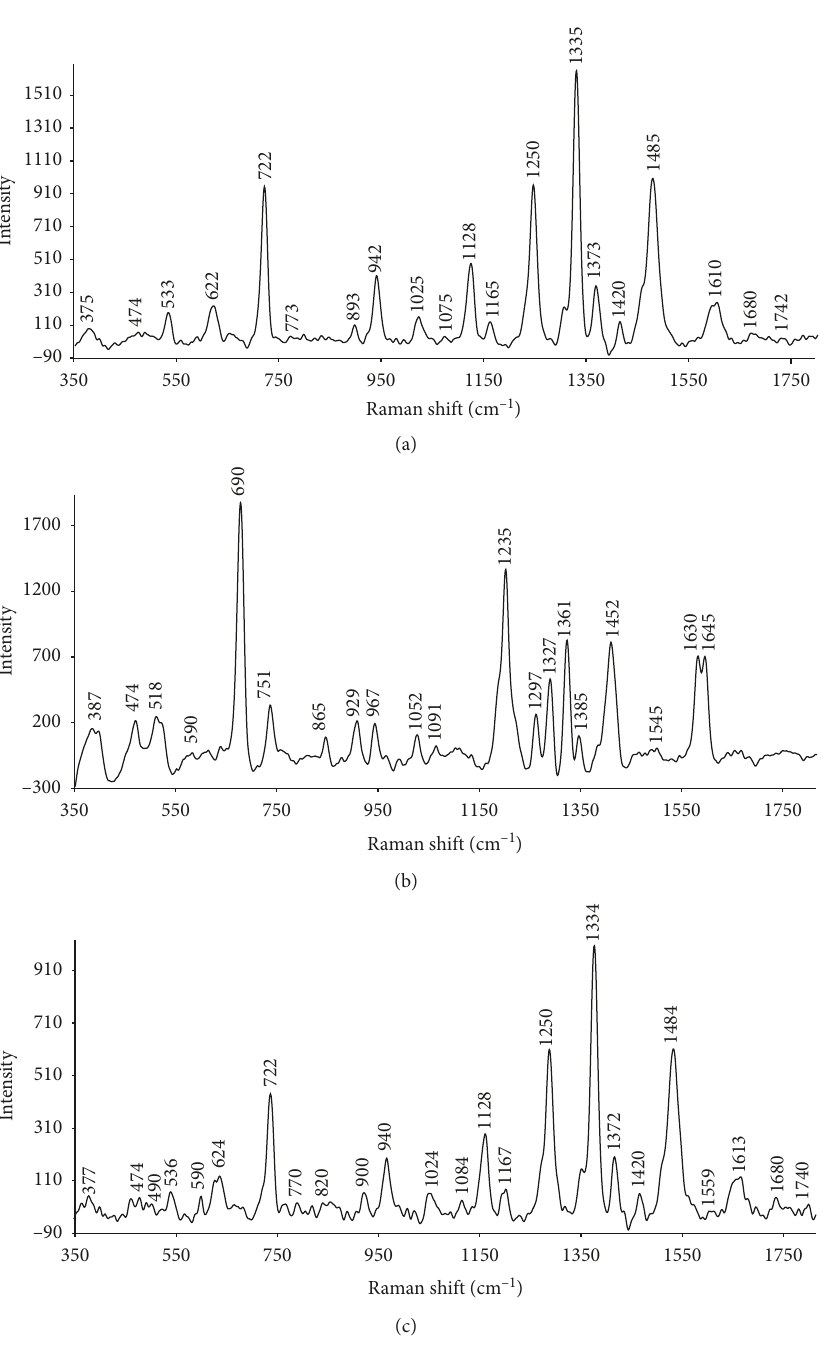
200mW). (b) Raman spectrum of (cid:30) 200mW). (c) Raman spectrum of aqueous solution of adenine- (cid:30) 200 (cid:30)